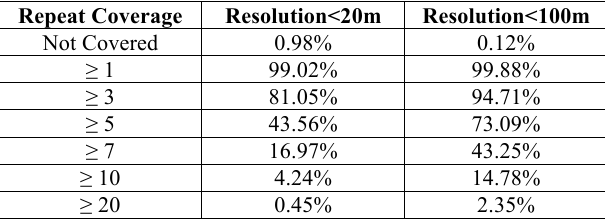
Table 2: Repeat Martian surface coverage with resolution finer than 100m (All), exclusively finer than 20m (Fine) and exclusively coarser than 20m and finer than 100m.